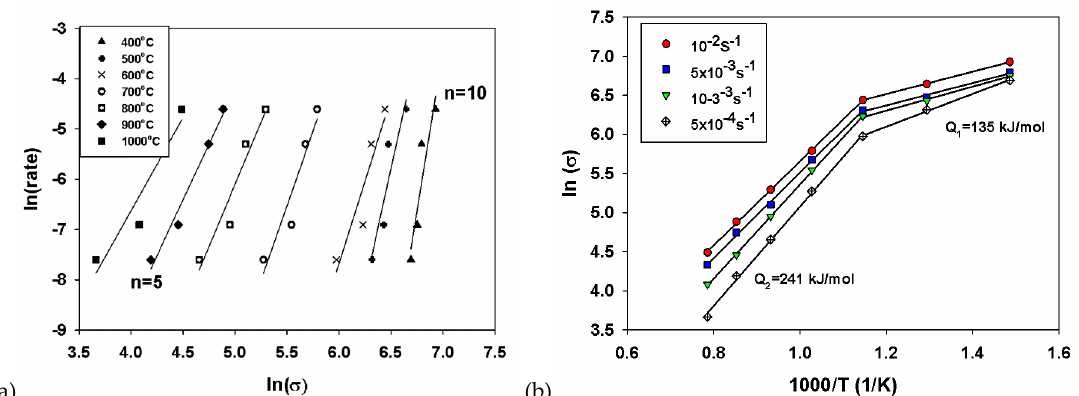
Figure 8. ( a ) Log–log dependence of strain rate on stress and ( b ) Arrhenius semi-log plot of steady- state flow stress vs. inversed temperature for the Ti-15Mo/TiB TMC strained in the interval T = 400– 1000 °